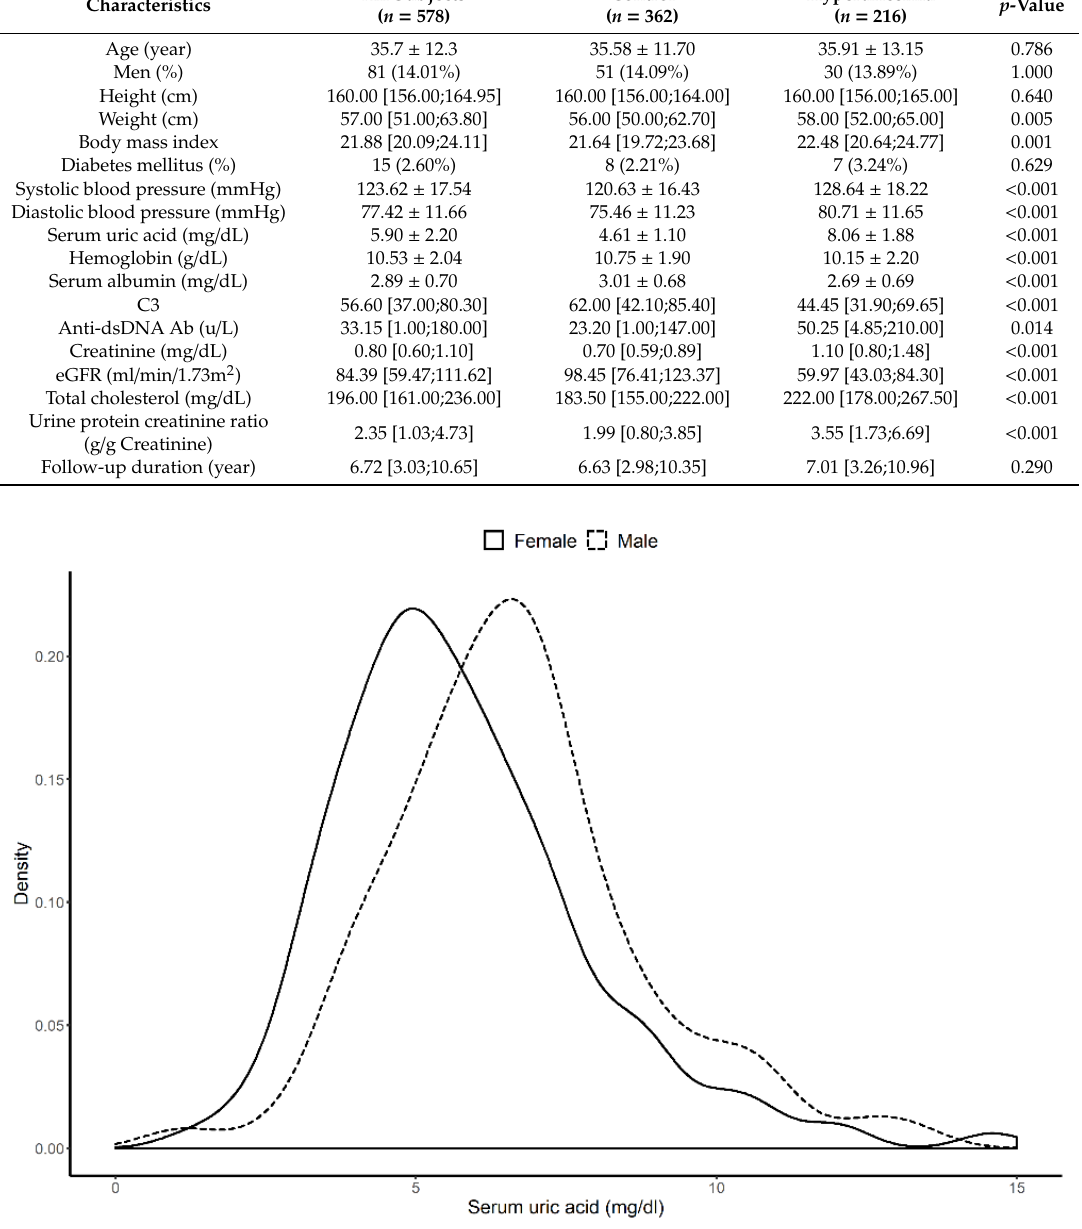
Figure 2. Difference in distribution of serum uric acid by sex. The median of serum uric acid level was